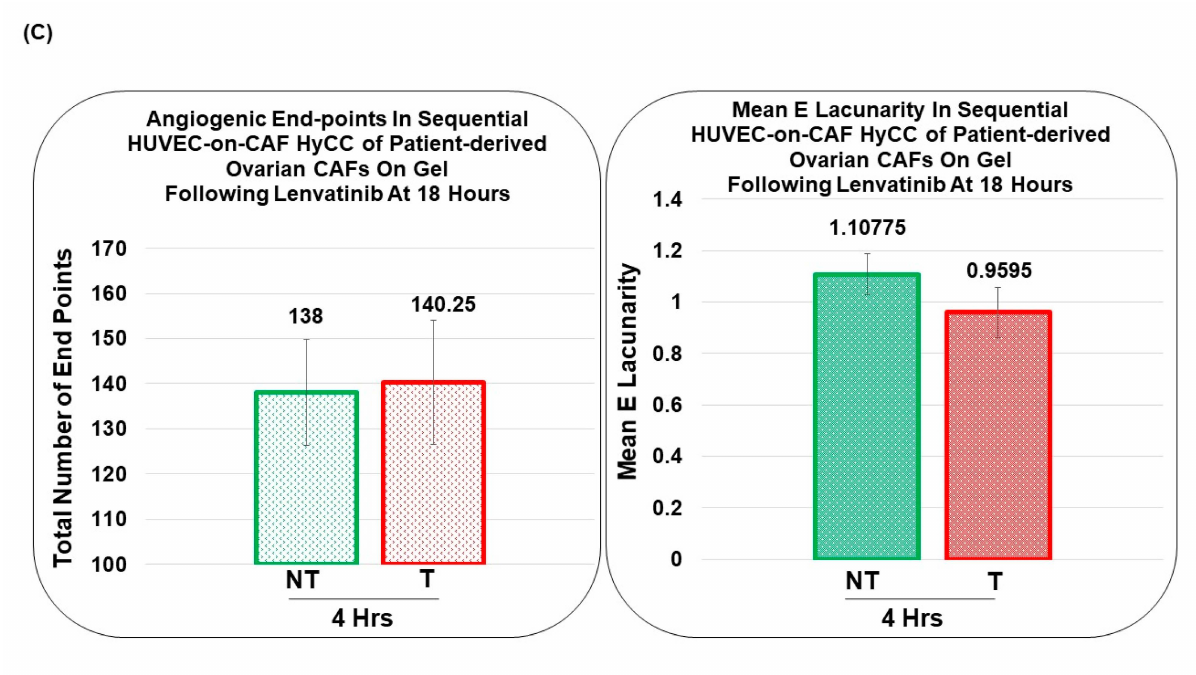
Figure 8. Effect of Lenvatinib on ex vivo on − gel sequential hybrid co − culture of HUVEC on Patient − Derived primary ovarian CAF for 18 h: We performed sequential Hybrid Co-Culture of HUVEC on Patient-Derived primary ovarian CAF for 18 h on-gel following lenvatinib ( A ). Angiogenic Scores ( B ) are determined by the polygons, junctions, and CAF clusters as well as angiogenic endpoints and mean E lacunarity ( C ). Matrigel tube formation assay of HUVECs cultured in HyCC format with Patient-Derived ovarian CAFs in control medium (green) or in the presence of 1 microM of lenvatinib (red) for 18 h. Angiogenic Endpoints (total number) (represented in Divot bars) and the mean E Lacunarity (represented in 40% filled bars) were detected with the AngioTool software (https://ccrod.cancer.gov/confluence/display/ROB2/Home [(access on 9 August 2022)]). Bars represent the mean and standard deviation of the mean.